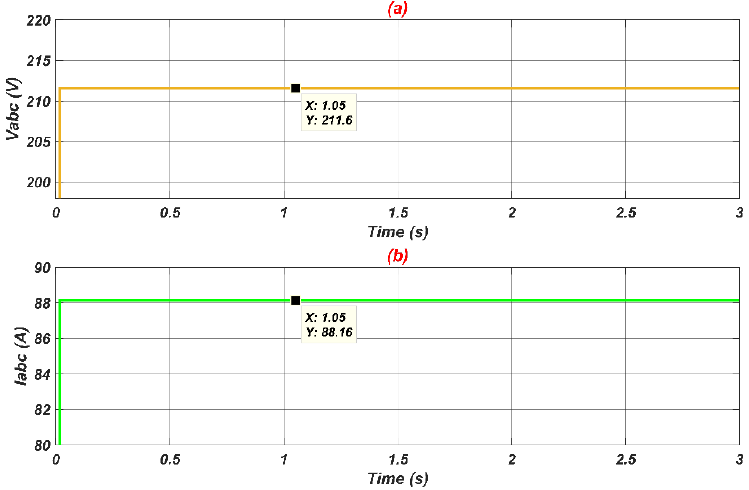
Figure 8. Measured RMS phase values: ( a ) voltages; ( b ) currents.